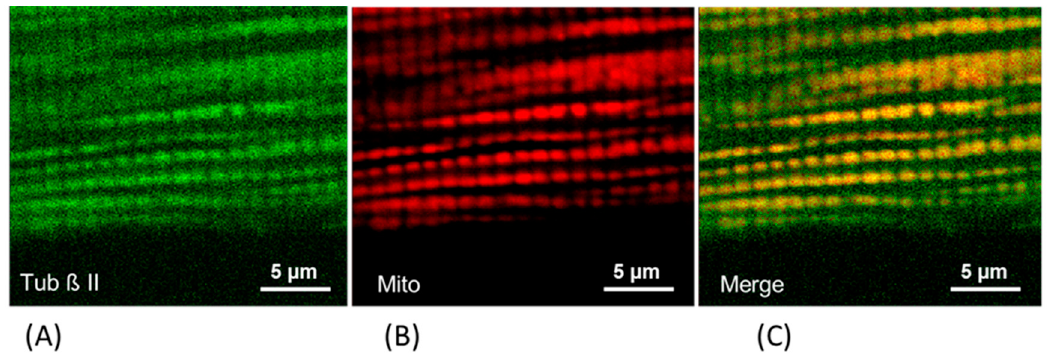
Figure 2. Fluorescence confocal evidence for the co-localization of the ( A ) tubulin beta II (Tub β II) (visualized by the specific antibodies against tubulin beta II, green), with mitochondria (Mito) ( B) visualized by the specific mitochondrial potential-sensitive probe tetramethylrhodamine methyl ester (TMRM, red). Merged image ( C ).